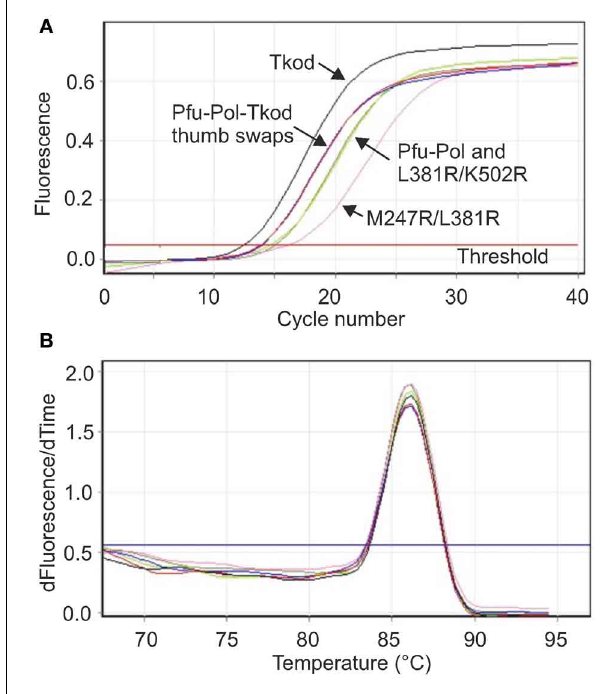
FIGURE 4 | Real time PCR analysis of polymerase performance. (A) Amplification of a stretch of yeast genomic DNA 232 bases in length using 10s extension. The lines that correspond to the individual polymerases are identified on the figure. Pfu-Pol TS and Pfu-Pol TS L381R/K502R (indicated Pfu-Tkod thumb swaps) gave near superimposable lines. Likewise the lines for Pfu-Pol and the double mutant L381R/K502R overlapped strongly. (B) Melting temperature analysis (first derivative showing the rate of change of temperature with time against time) of the amplicons generated in (A) . All the polymerases gave exclusively the desired product as indicated by a single peak with a T m of 86 ◦ C. As all the lines are essentially identical the individual polymerases have not been identified. In both panels only a single line for each polymerase is shown but all experiments were carried out in